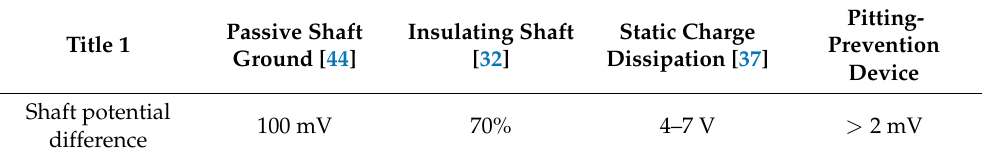
Table 5. Performance comparison of anti-corrosion